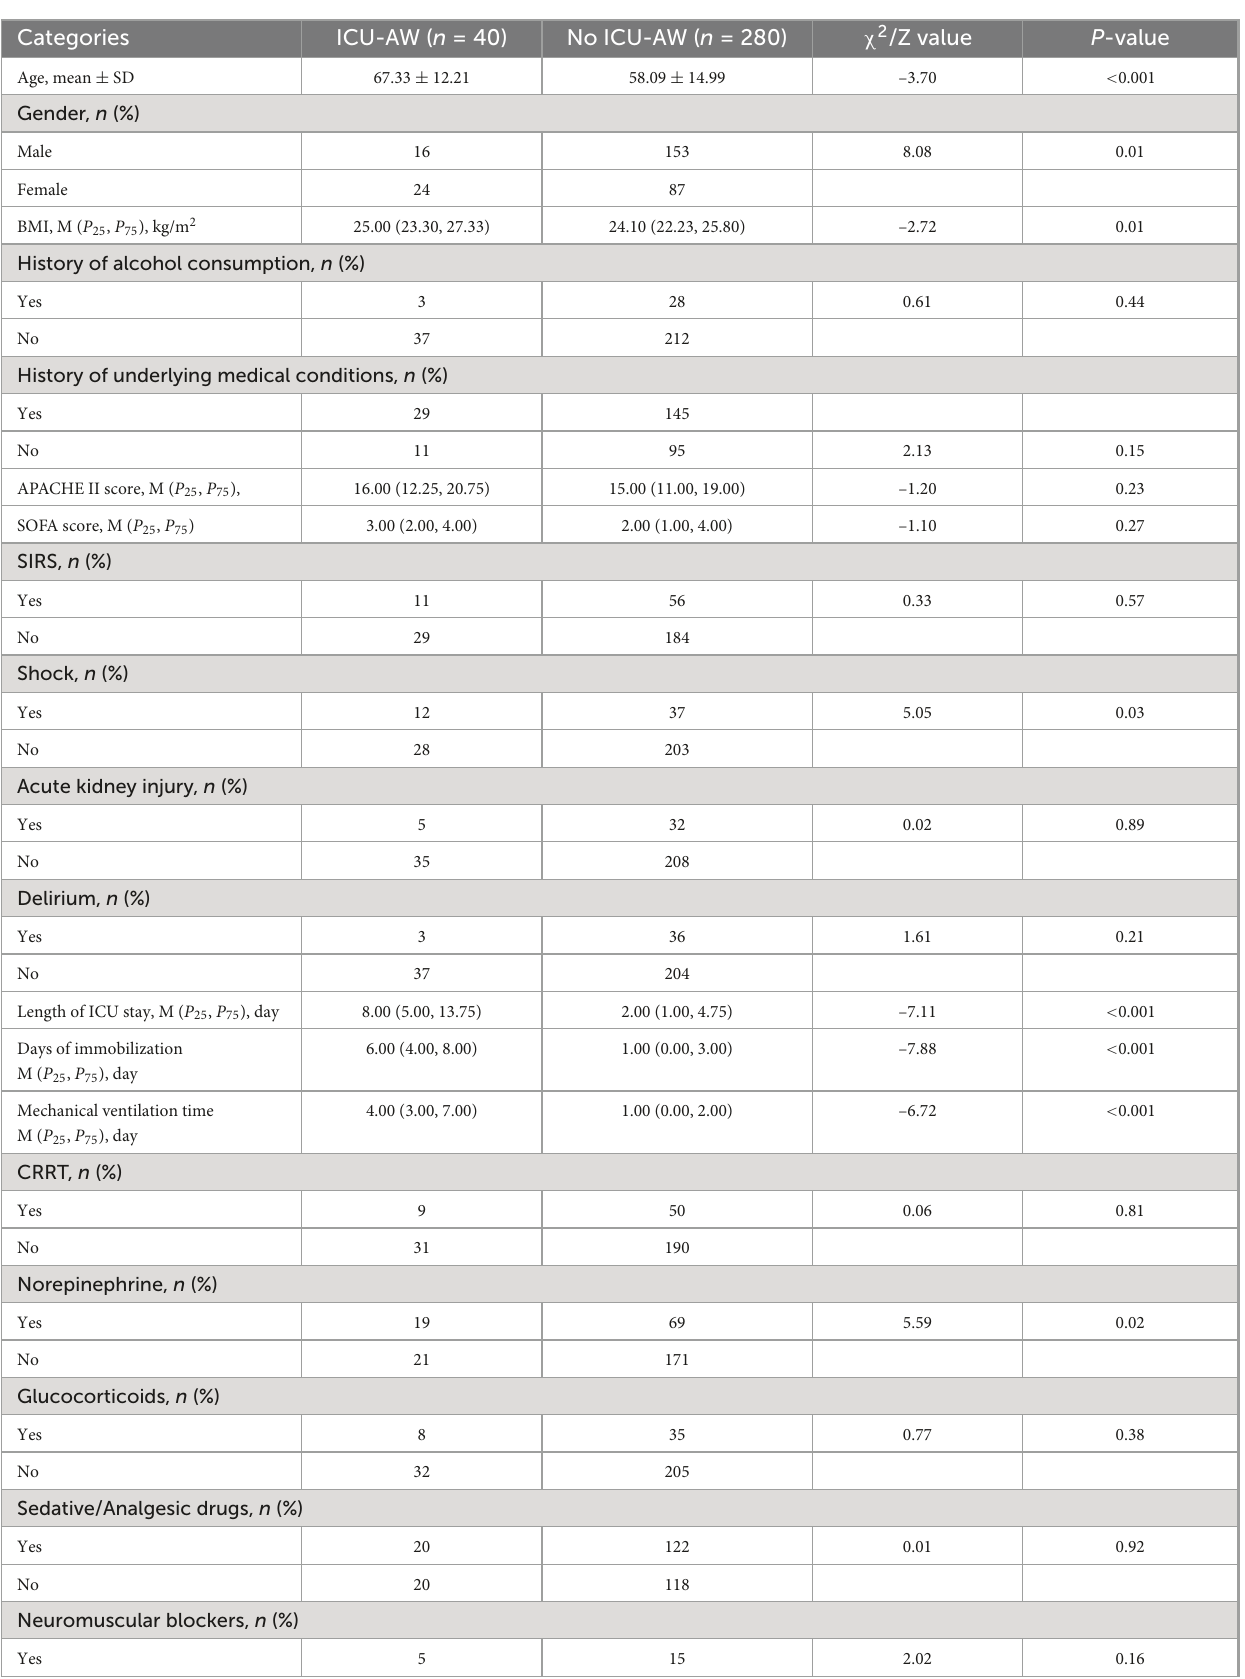
TABLE 5 Univariate analysis of intensive care unit acquired weakness (ICU-AW) risk